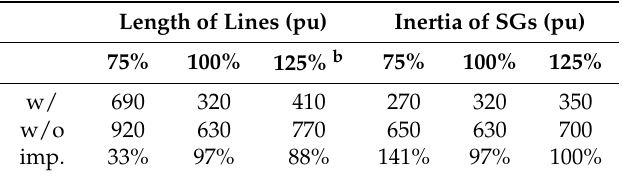
Table 6. CCT (ms) results under different grid